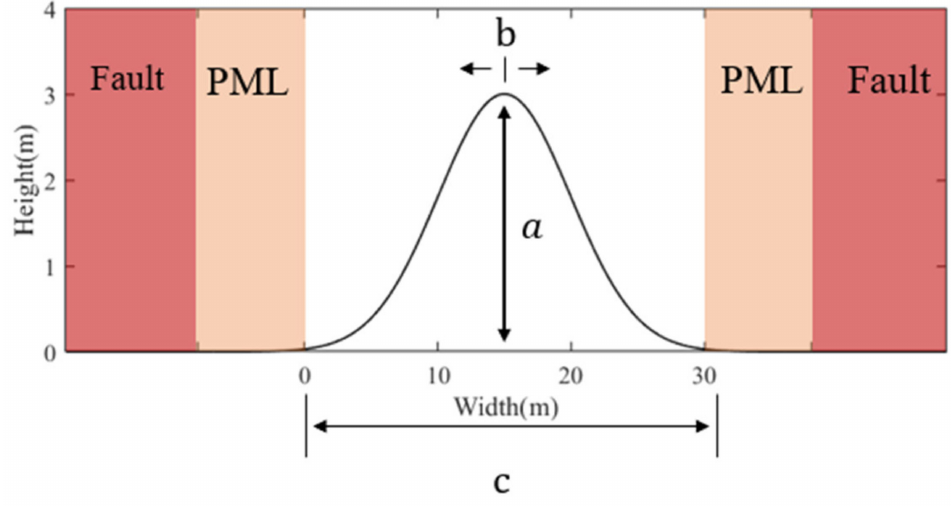
Figure A4. Gaussian curve used to control the fold shape.